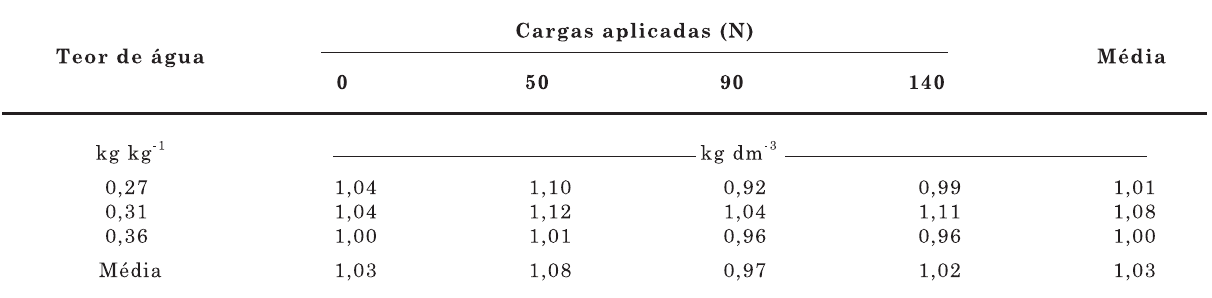
Quadro 3. Densidade média do solo na região da semente de acordo com o teor de água e a carga